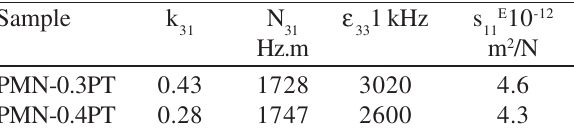
frequency constant N for the PMN-0.3PT and PMN-0.4PT ceramics (24 h after the poling